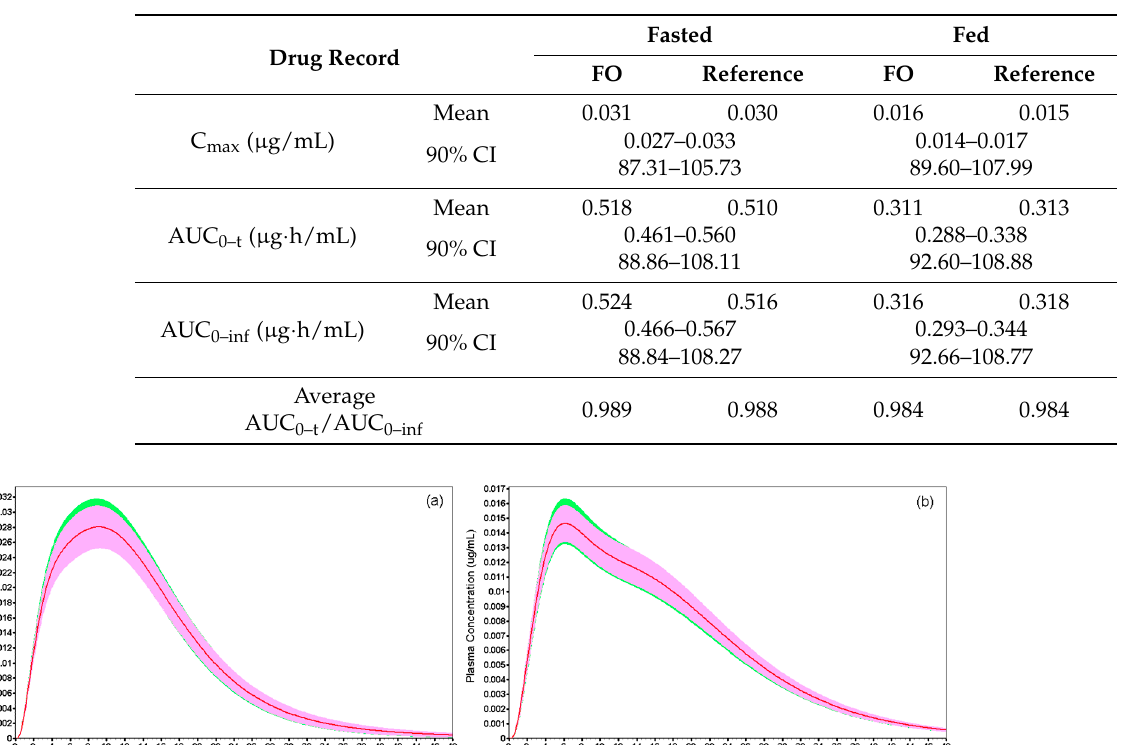
Table 13. VBE data for 95 mg CR tablets in fasted and fed states.